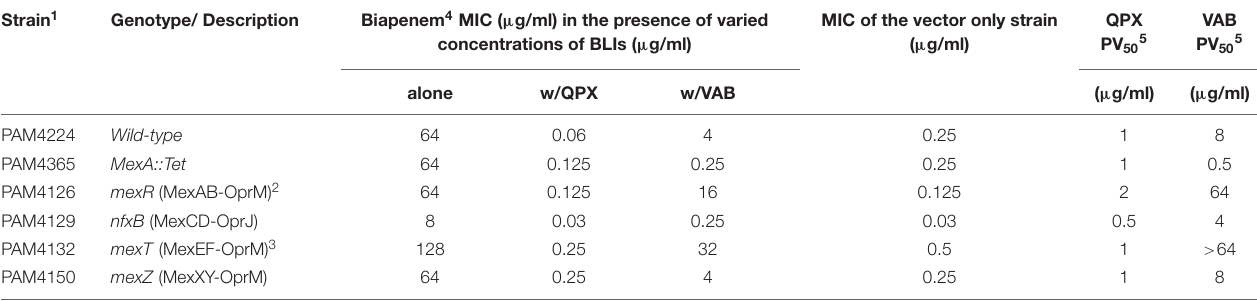
TABLE 4 | Evaluation of the impact of various efflux mutations on potency of QPX7728 (PV 50 ) to enhance antibiotic activity. Strain 1 Genotype/ Description Biapenem 4 MIC ( µ g/ml) in the presence of varied MIC of the vector only strain concentrations of BLIs ( µ g/ml) ( µ g/ml)